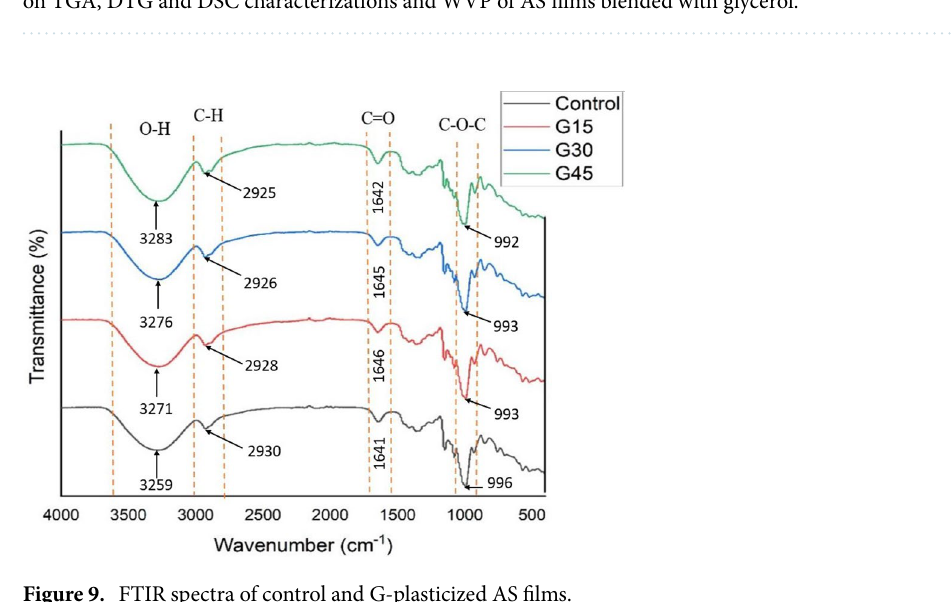
Table 3. Effect of glycerol concentrations on thermal properties of control and G-plasticized AS films based on TGA, DTG and DSC characterizations and WVP of AS films blended with glycerol.